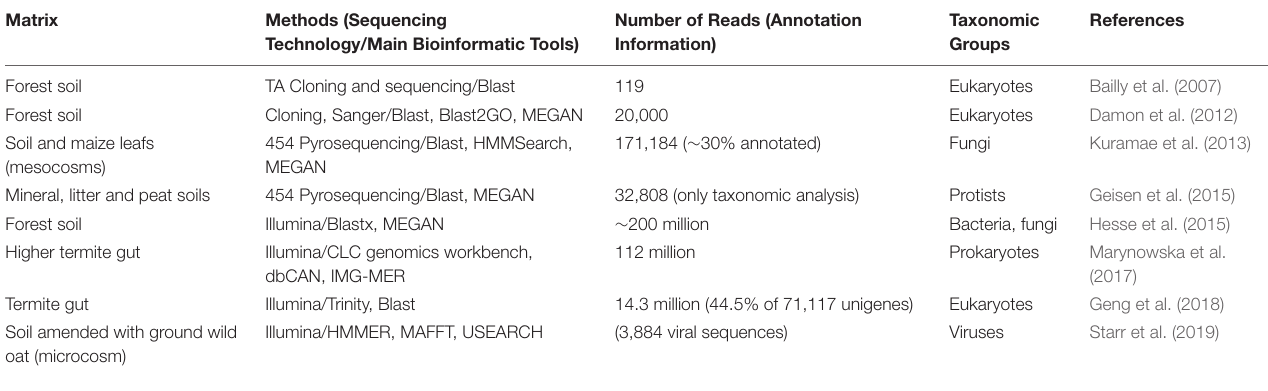
TABLE 5 | Selected metatranscriptomic studies indicating number of reads using different sequencing technologies for a variety of materials from biological situations that present similarities to retting.